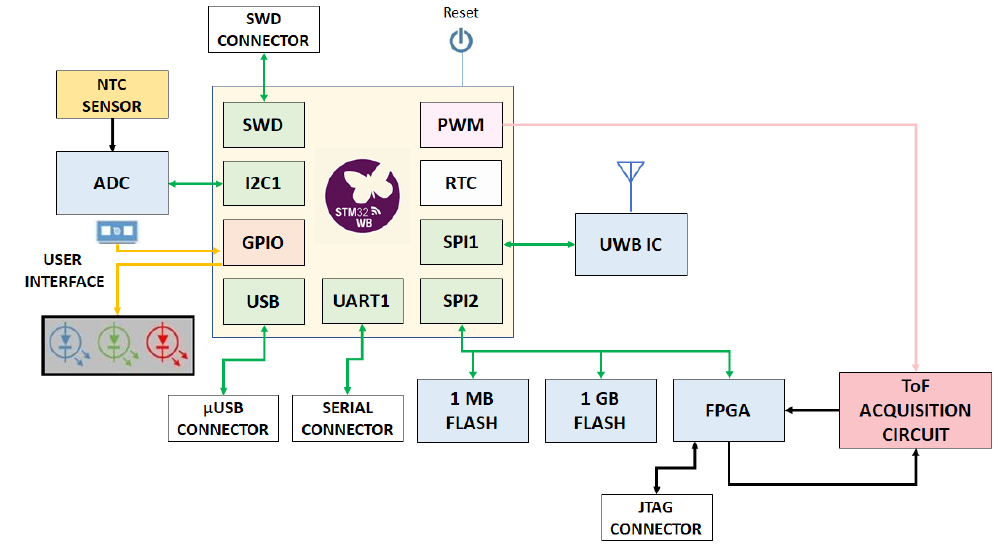
Figure 3. Sensor Node